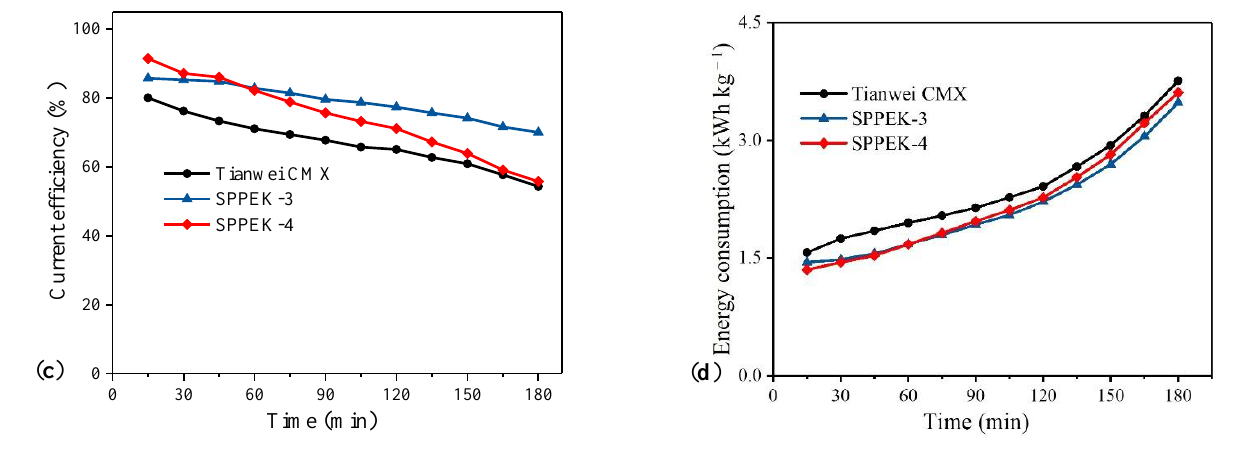
Figure 10. The ED performance of SPPEK-3, SPPEK-4 and CMX membranes for saline water, ( a ) ion conductivity of saline solution in DC and CC; ( b ) the final salt removal rate; ( c ) current efficiency; ( d ) energy consumption of ED equipment.